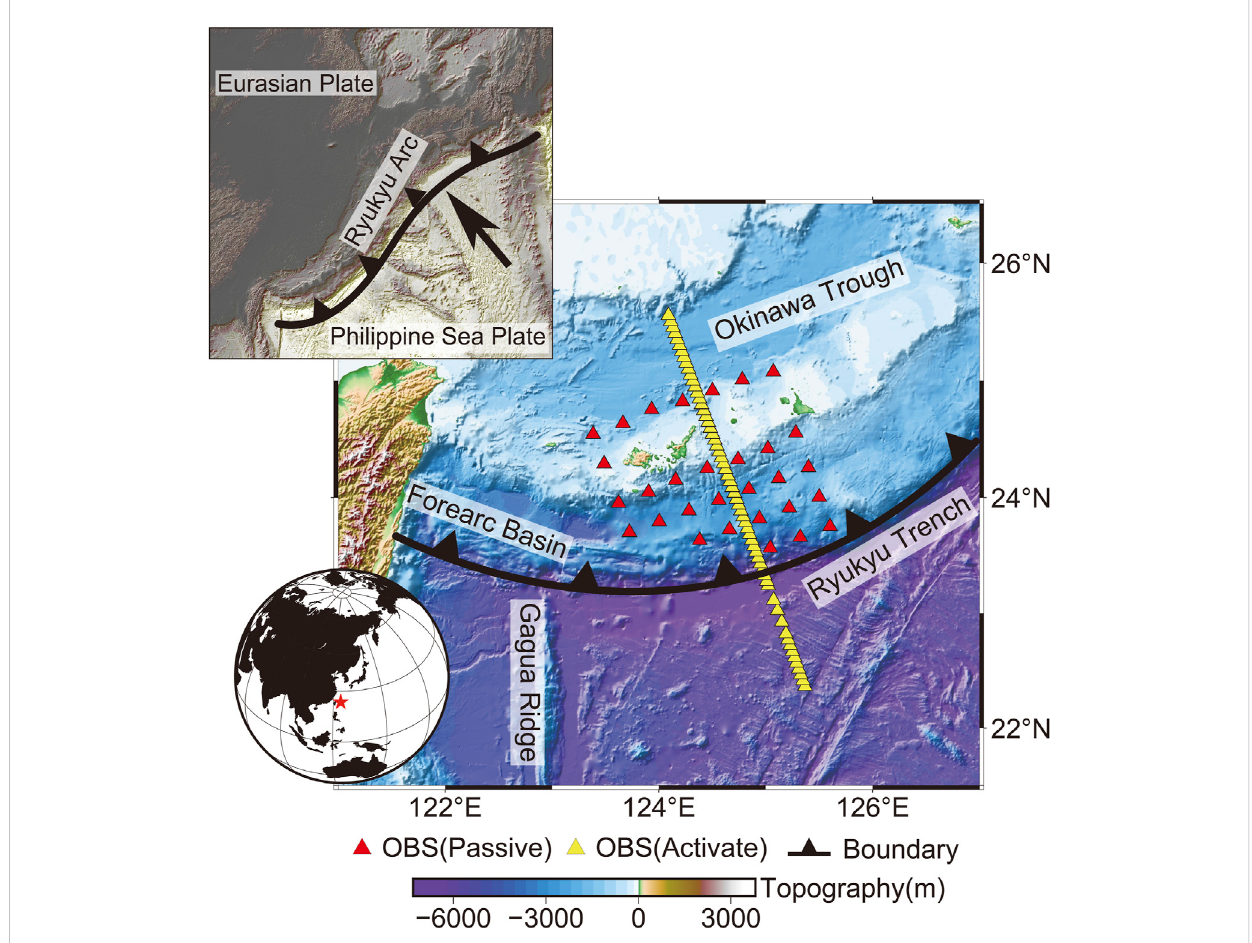
FIGURE 1 LocationsofOBSsandlandstationsintheRyukyuTrench,wheretheredandyellowtrianglesrepresentOBS(Passive)andOBS(Active),respectively, and the sawtooth line represents the plate boundary between the Eurasian Plate and the Paci fi c Plate (Plate boundary data from Nishizawa, (2009)).